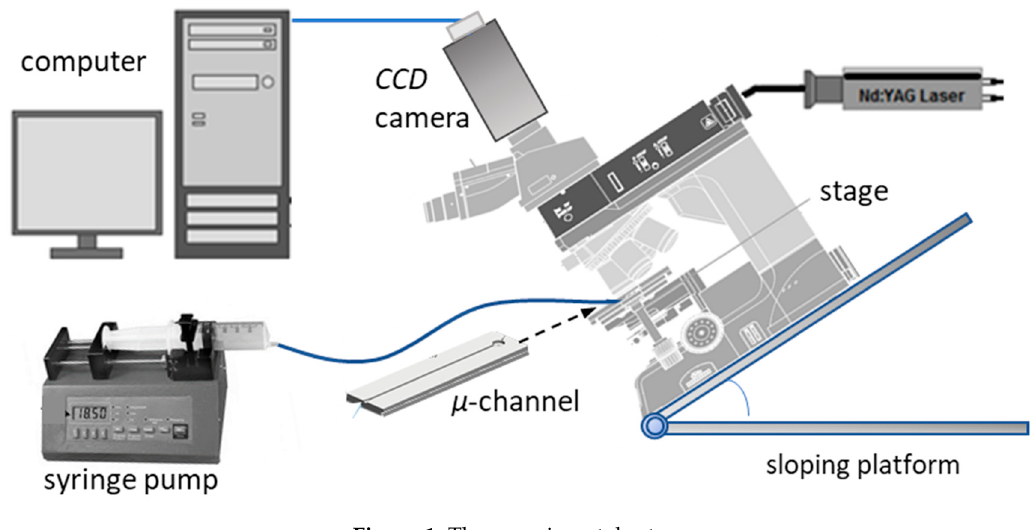
Figure 1. The experimental setup.